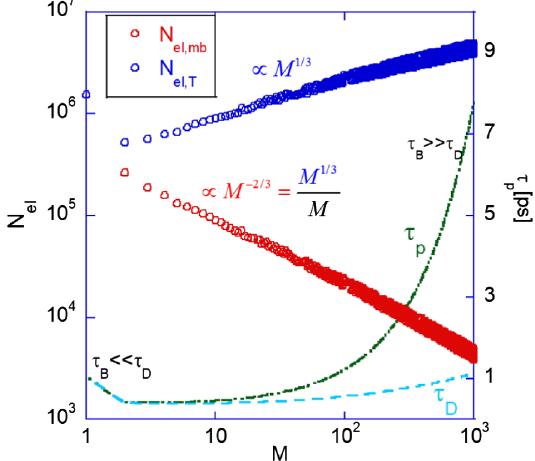
FIG. 4. Left vertical axis: Total optimal charge in the train (blue) increases moderately as a function of number of micro- bunches in the train ( M ), while the charge in a microbunch (red) decreases by two orders of magnitude. Right vertical axis: Pulse length (green) and delay time (dashed turquoise) for which maximum efficiency and optimal charge